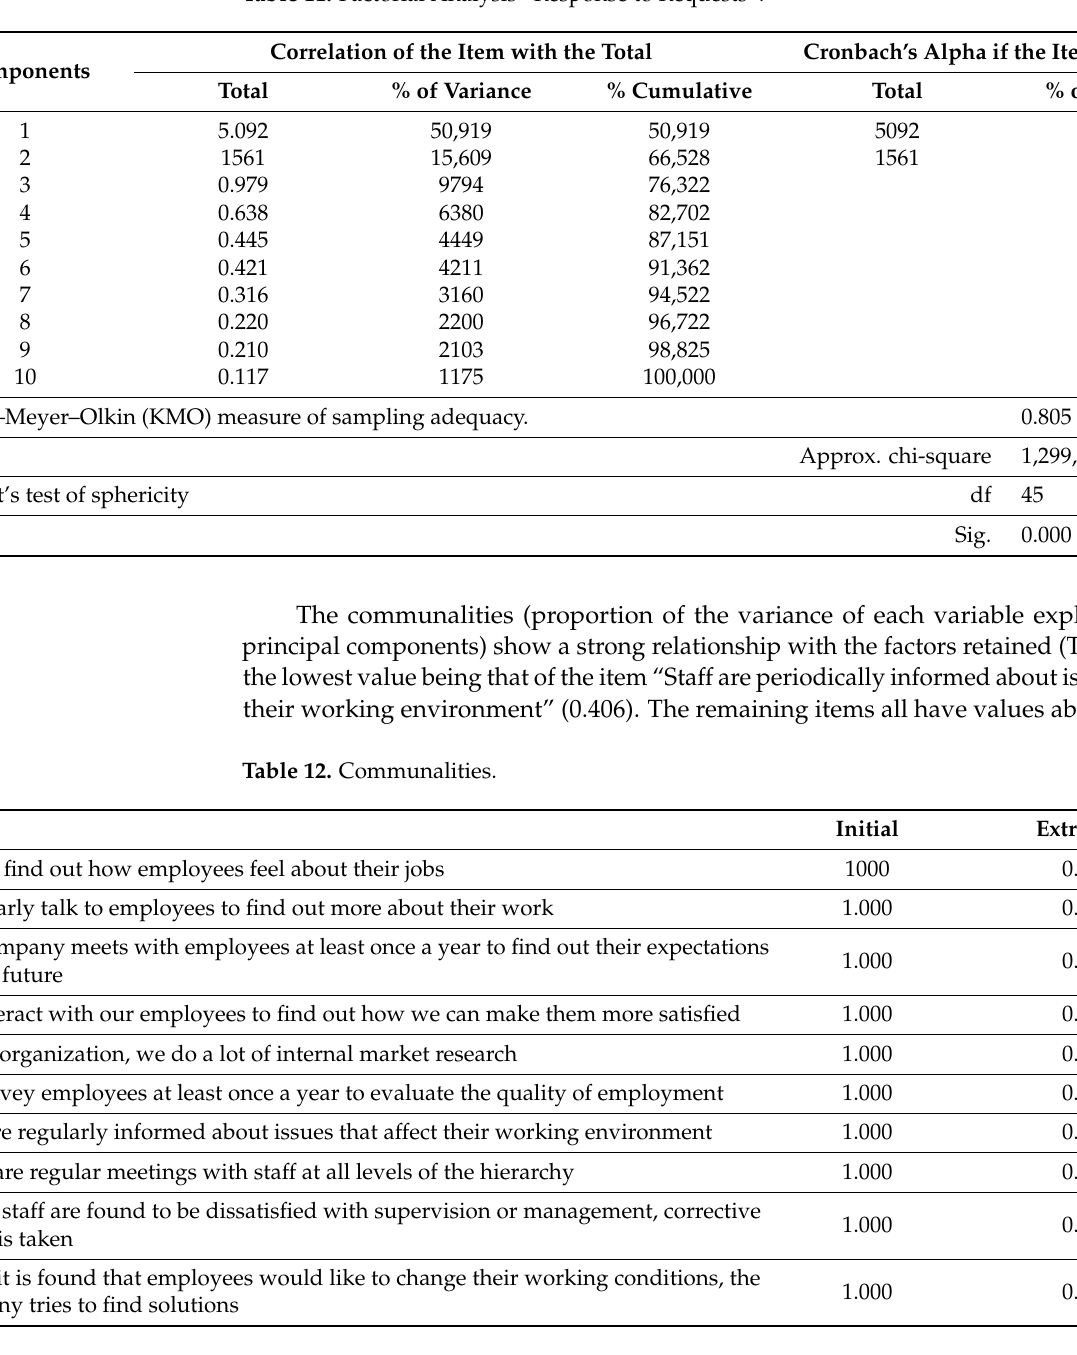
Table 11. Factorial Analysis “Response to Requests”.